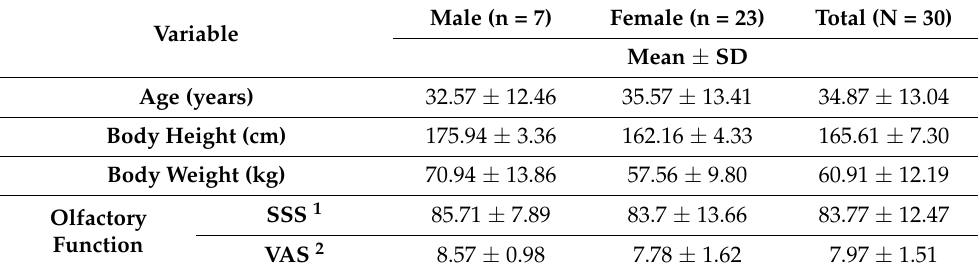
Table 2. Descriptive characteristics of the participants (N =